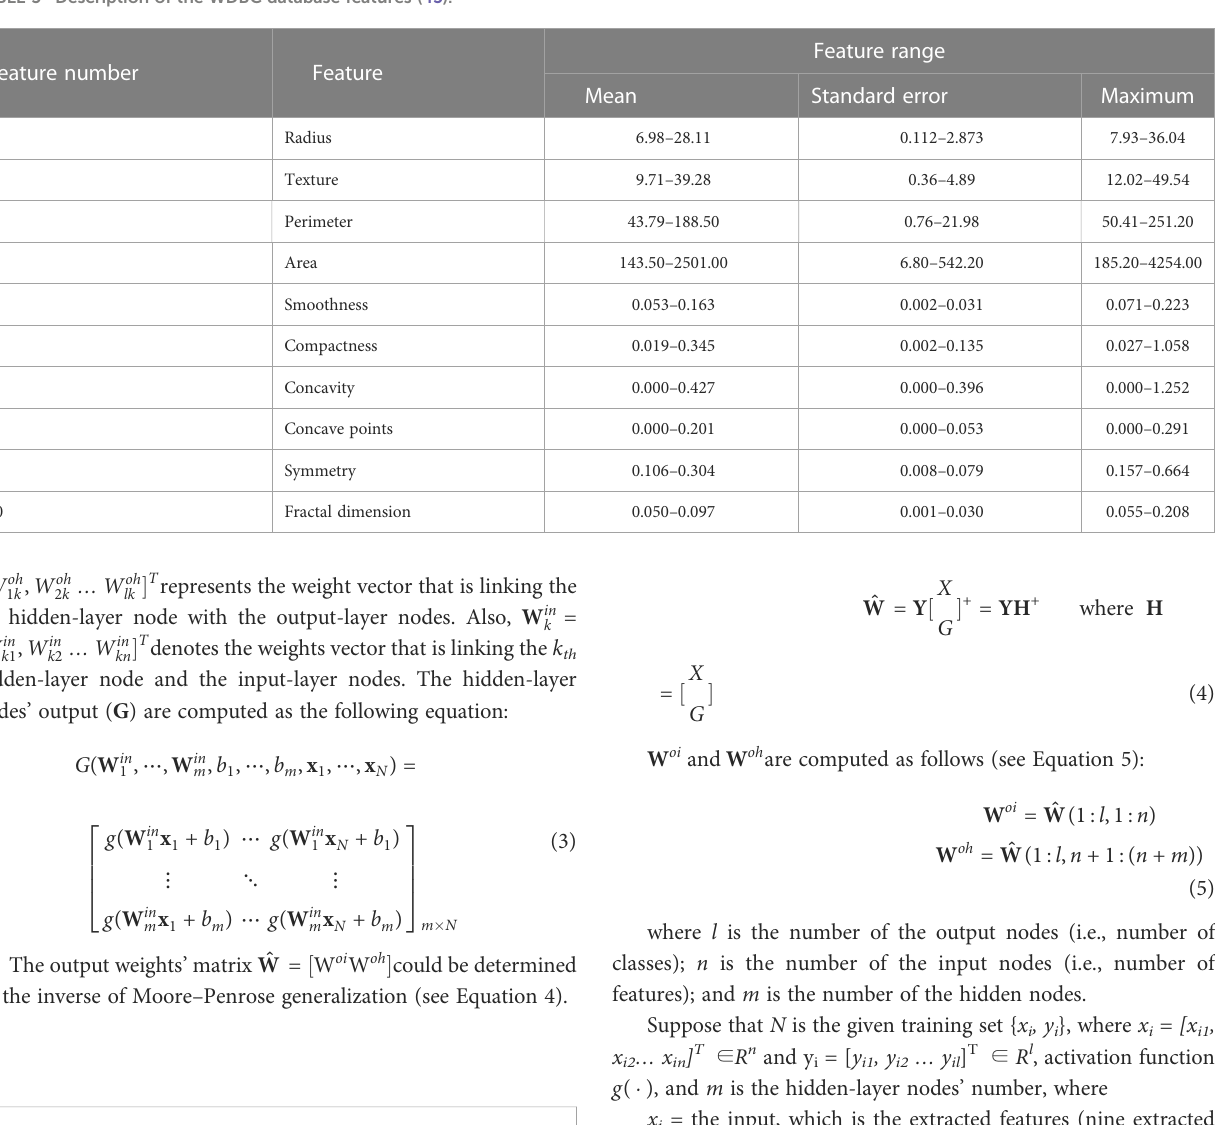
TABLE 5 Description of the WDBC database features (45).